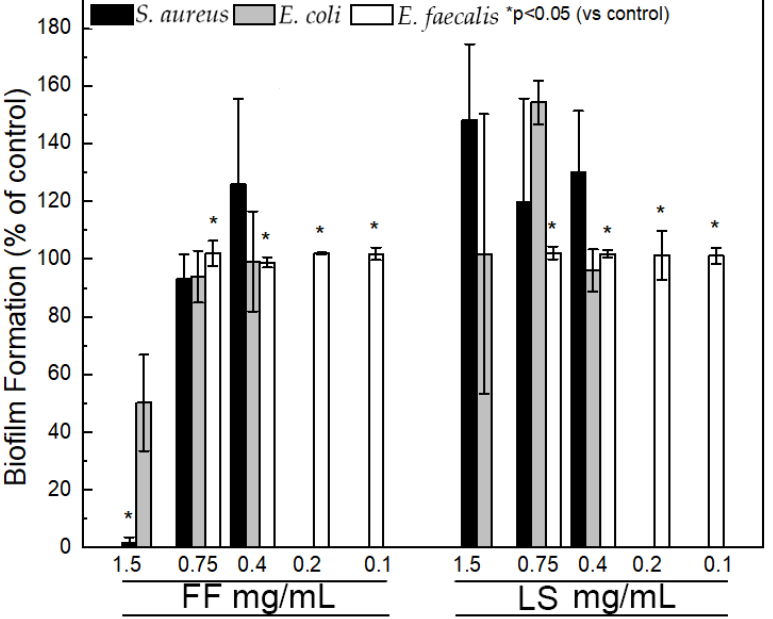
Figure 4. Biofilm formation for S. aureus ATCC 29213 (black), E. coli ATCC 25922 (gray) and E. faecalis ATCC 29212 (white), shown as percentage of control.